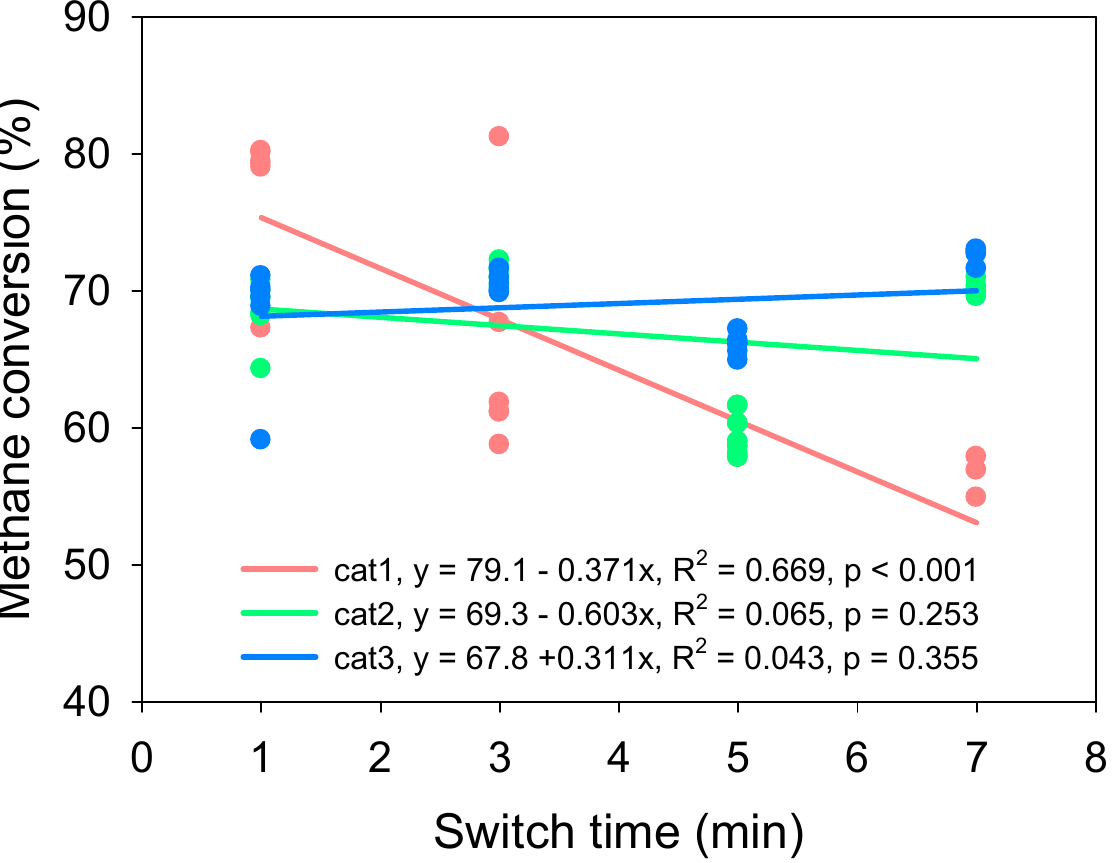
Figure 8. Correlation of switch time and methane conversion. Start-up conditions: reaction temperature: 800 °C, methane inlet concentration: 0.7%, methane inlet velocity: 1.2 m 3 /h.